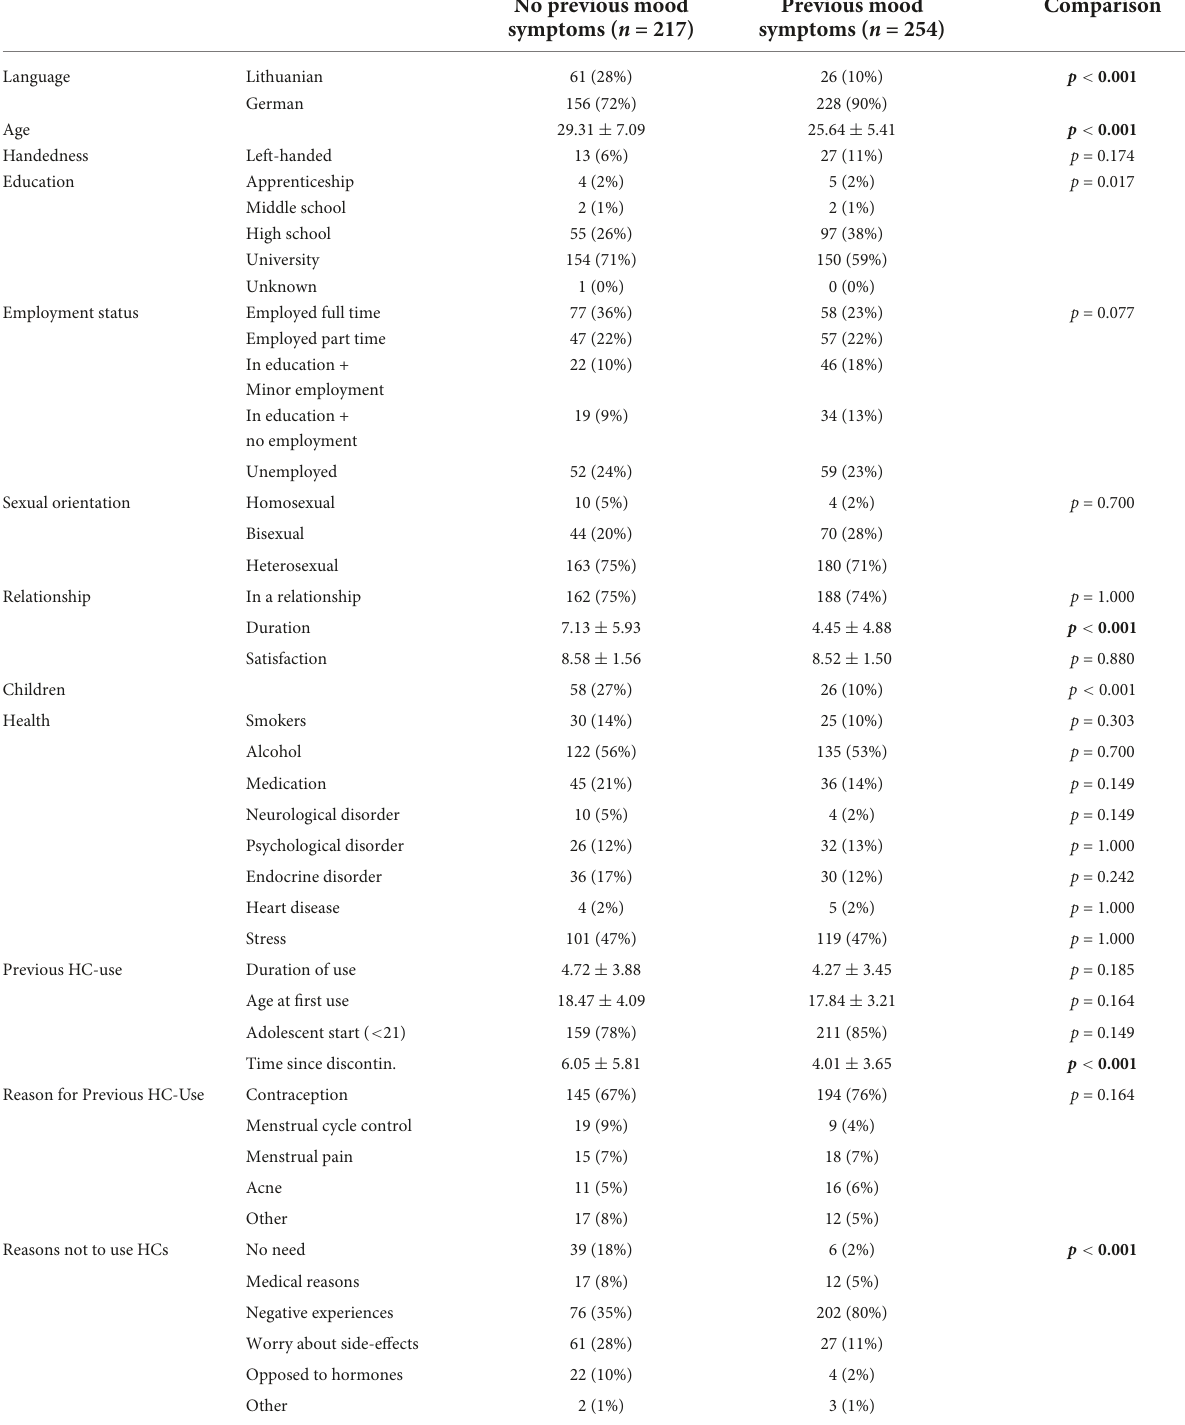
TABLE 7 Comparison of previous HC-users with and without emotional symptoms along demographic variables.